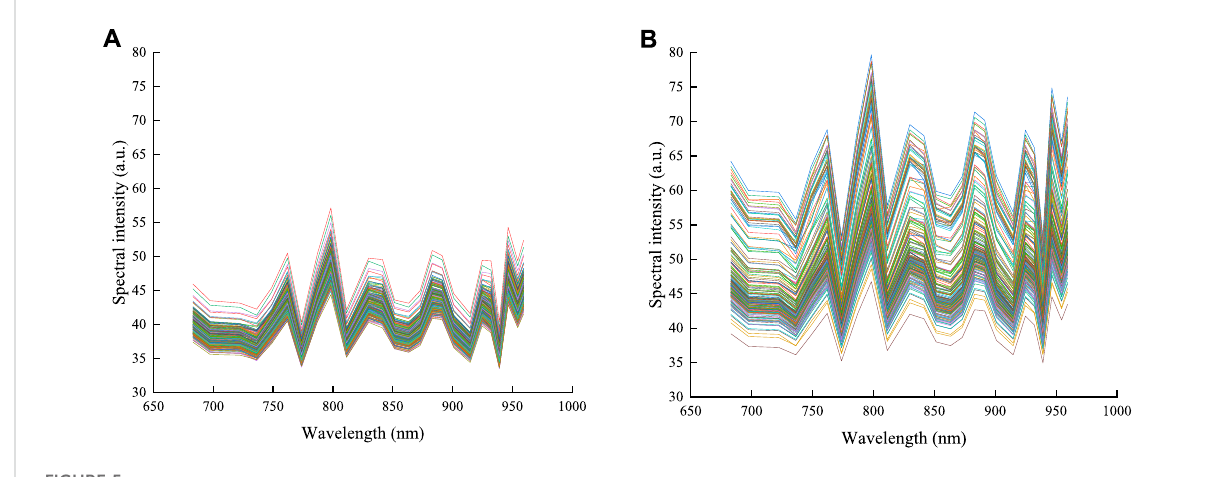
FIGURE 5 Spectral curves of multispectral imaging for coal and gangue. (A) Coal and (B)